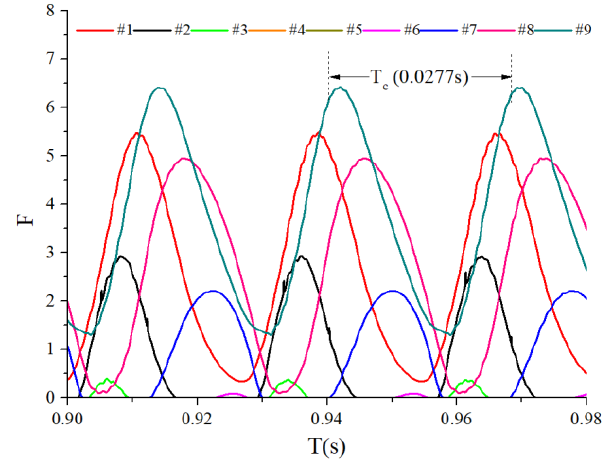
f = 8 N). f = 8 N). f = 8 N). ce ce